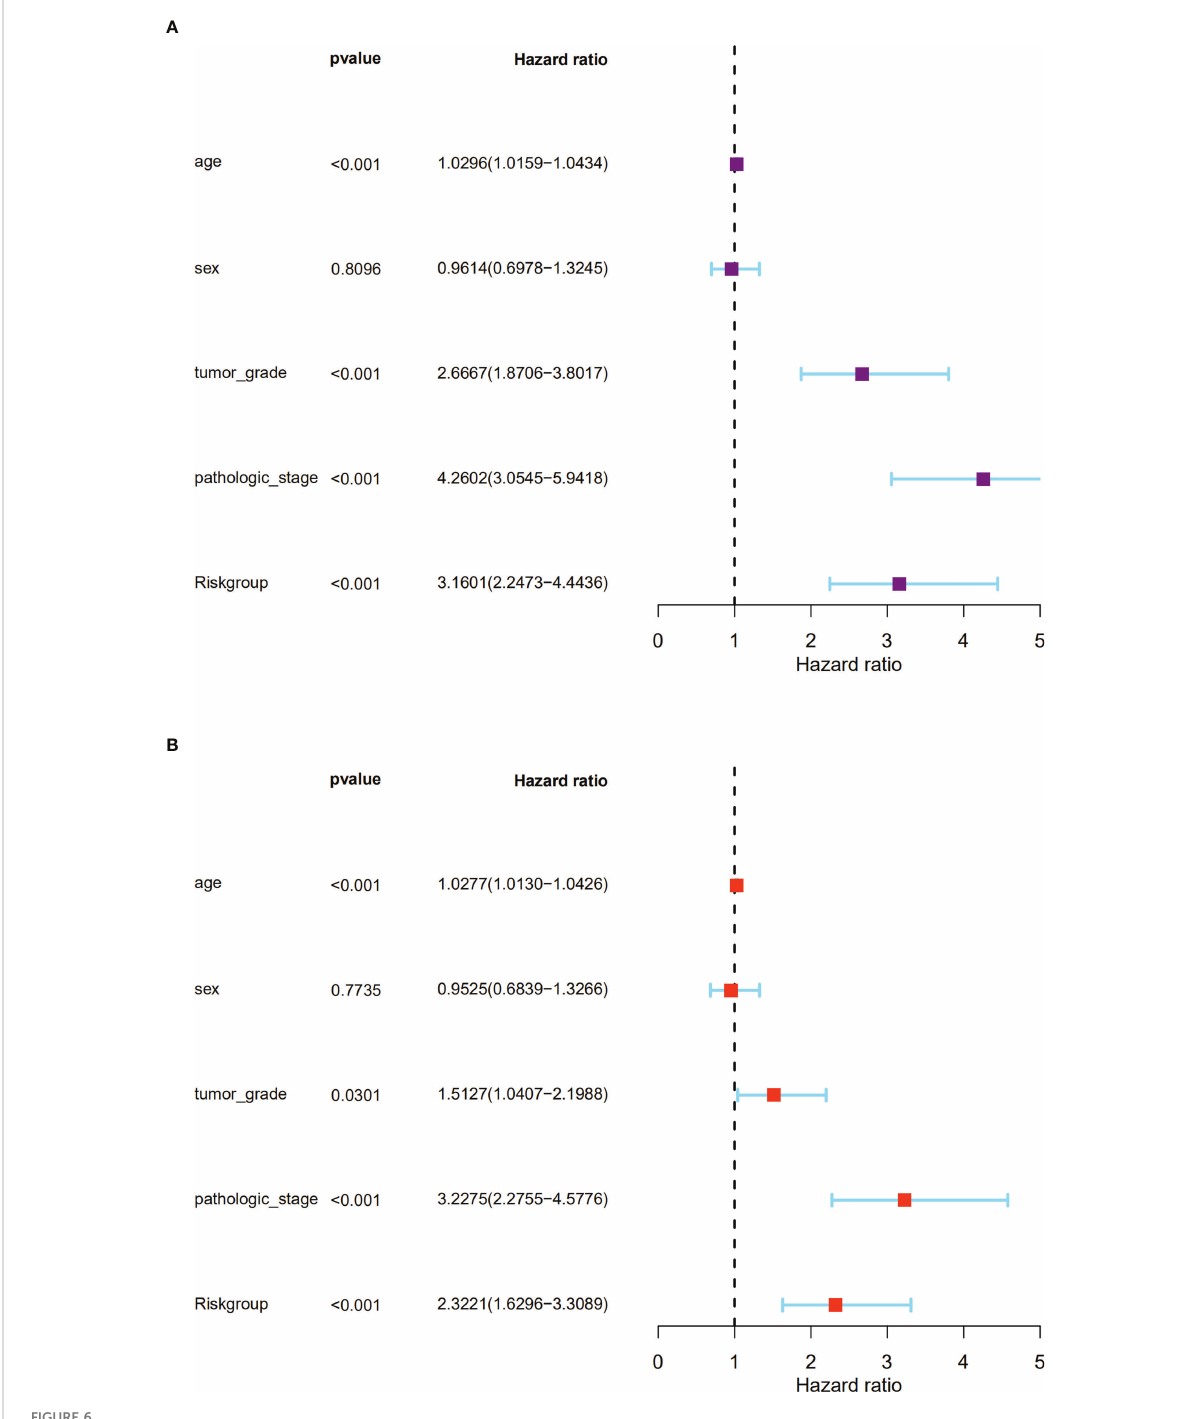
FIGURE 6 The signature could predict the prognosis of ccRCC patients in the TCGA dataset independently. (A). The univariate Cox regression analysis; (B). The multivariate Cox regression analyses showed the associations of the risk score predicting overall survival with clinicopathological